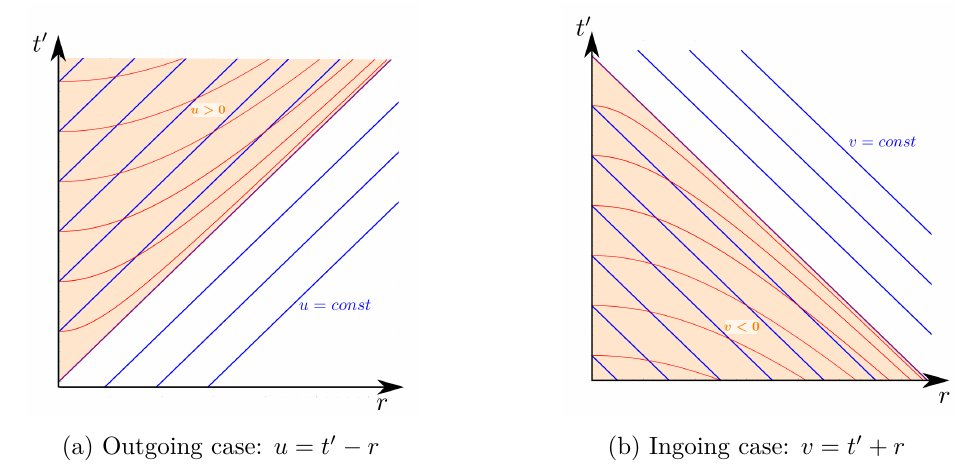
Figure 3. The region in orange shows, in the ( r, t 0 ) space, the patch covered by the hyperbolic system of coordinates adapted to outgoing (see figure 3(a)) or ingoing (see figure 3(b)) null geodesics. The straight lines in blue represent null geodesics, while the red lines represent (one side of) the hyperbolic slices at fixed time σ